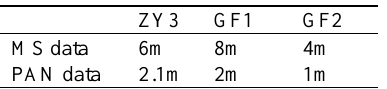
Figure 3. Flowchar of obtaining spot area data model